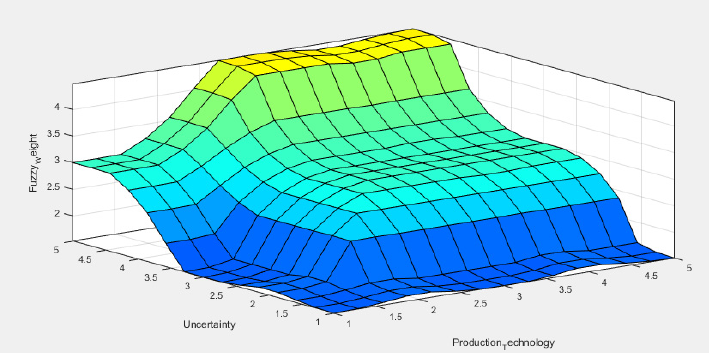
Figure 9. Three-dimensional graphical view of the FIS model.